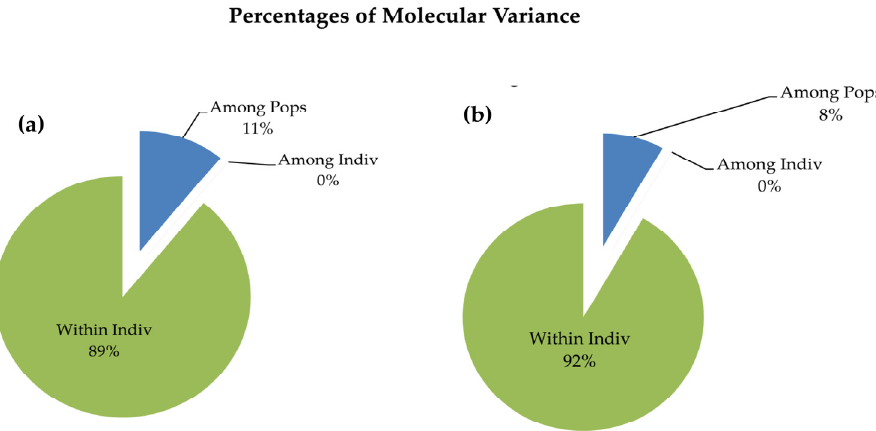
Figure 5. AMOVA analysis depicting variation among populations and within individual accessions. ( a ) The AMOVA analysis based on geographical origin, and ( b ) AMOVA analysis based on model-based population structure analysis. Table 3. Percentage of cumulative variation explained by the first three axes among amaranth accessions in PCoA analysis.